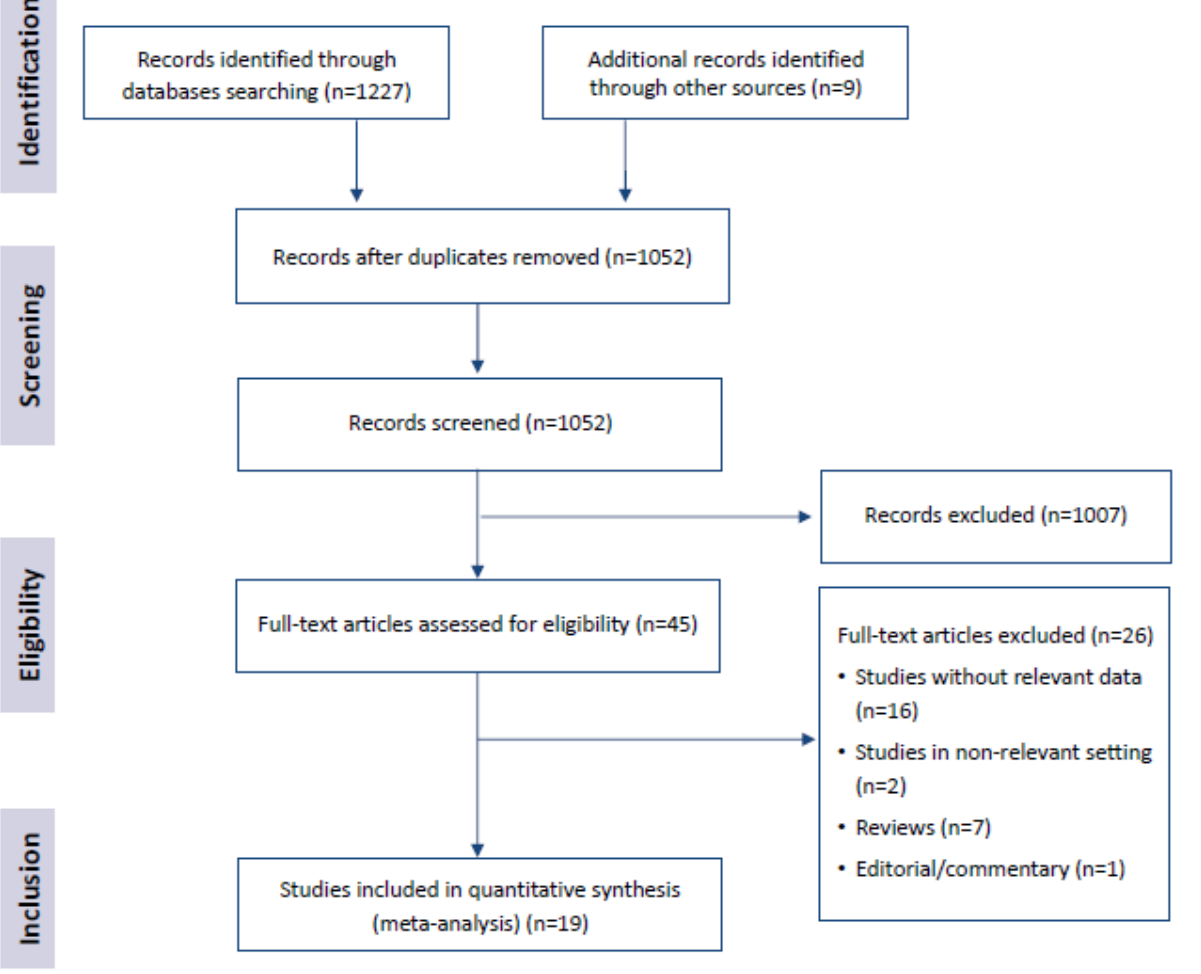
Figure 1. Literature search flow.